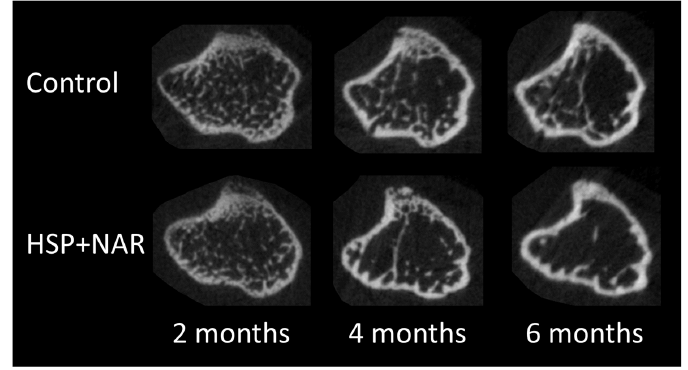
Figure 2. Representative grayscale transaxial images of right proximal tibias of female CD-1 mouse offspring at 2, 4, and 6 months of age.